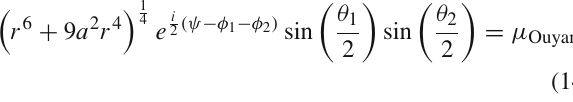
Fig. 1 Dasgupta et al’s [2] Type IIB brane construct and the gravity dual of large-N QCD at high temperature, and their (SYZ) mirrors